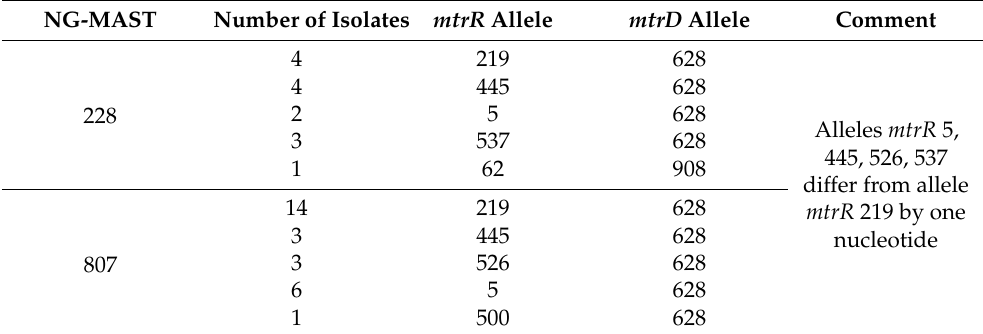
Table 2. Characteristics of N. gonorrhoeae isolates belonging to the sequence types most common in the Russian Federation. NG-MAST Number of Isolates mtrR Allele mtrD Allele Comment 4 219 628 228